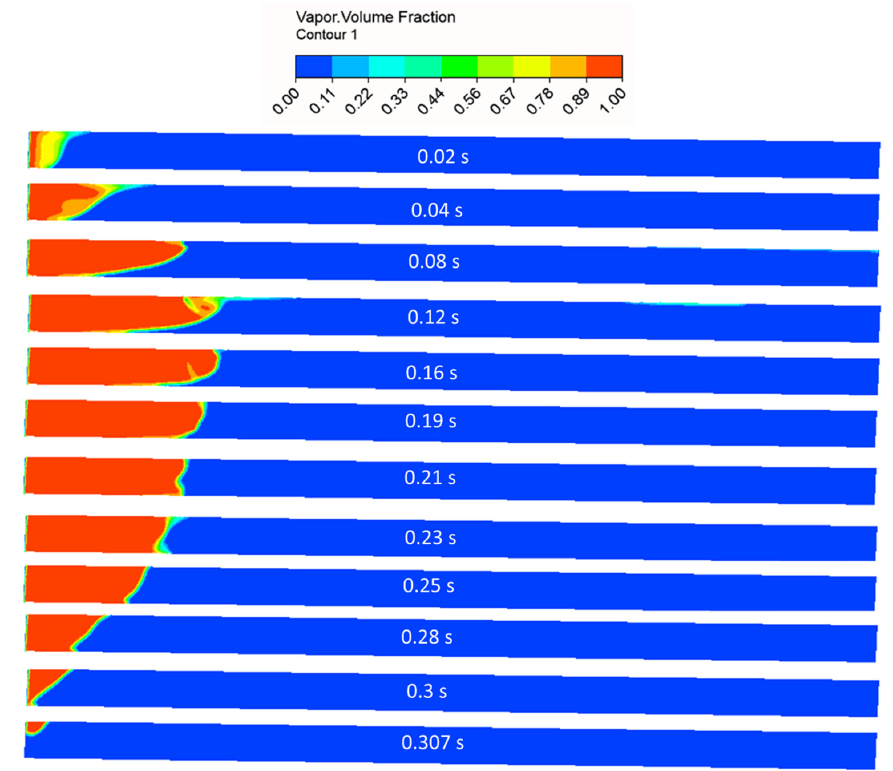
Figure 6. Pressure time histories calculated by 1D-2D at; ( a ) valve; ( b ) pipe mid-point.